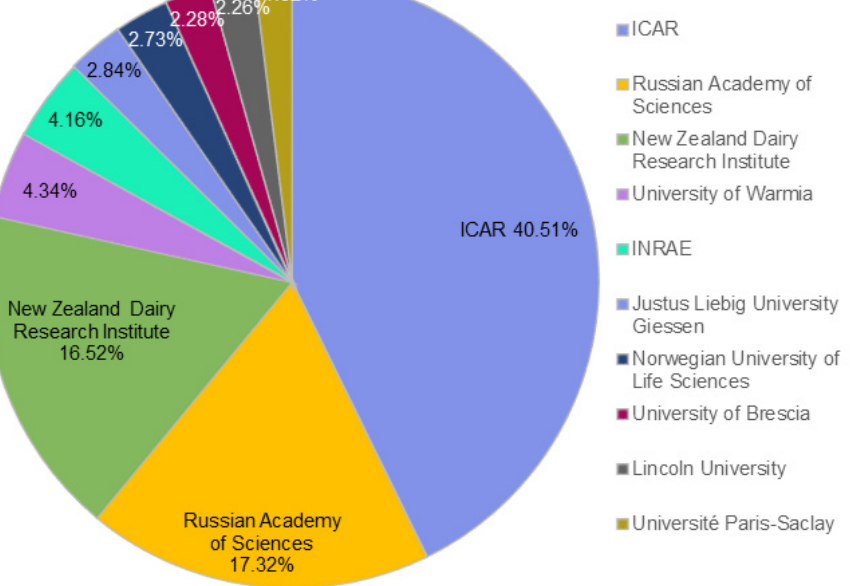
Figure 6. The top 10 most important affiliations in the A2 β -casein research field. The number of publications which referred to A2 β -casein in each affiliation area was relativized with respect to the total number of publications of each affiliation area in order to show the real importance of each affiliation in the A2 β -casein field.